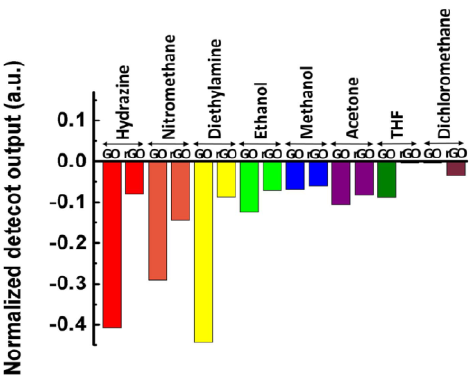
Figure 13. Comparative plots of the sensing responses of GO and rGO to eight different vapours at a 500 ppb concentration level. Reprinted from [133].